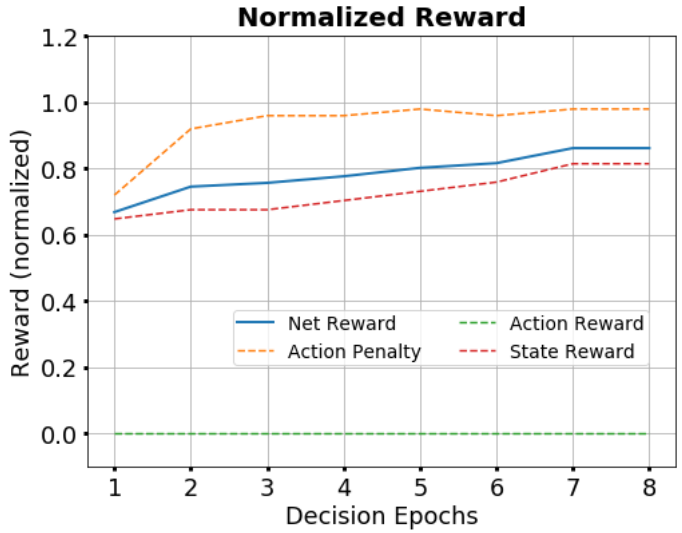
Figure 25. Progression of the rewards associated with 𝑎 𝑠𝑒𝑞2 .